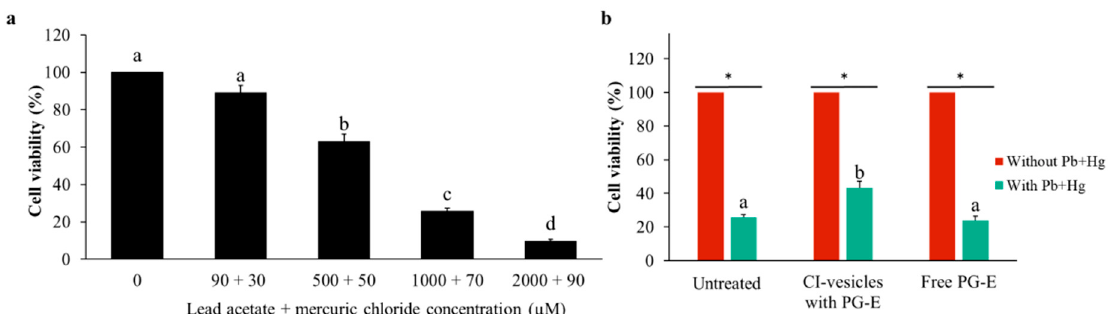
Figure 6. Viability (determined by the MTT assay) of HaCaT cells incubated for 24 h with different combinations of lead acetate and mercuric chloride ( µ M) ( a ) and treated for 24 h with cauliflower inflorescence vesicles (CI-vesicles) with pomegranate extract (PG-E) or free PG-E previous to the application of heavy metals (1000 µ M lead acetate + 70 µ M mercuric chloride) ( b ). The results were normalized as a function of the control cytotoxicity. Data are means ± SE ( n = 6). Different letters indicate significant differences between groups. *, significant differences compared to the respective control ( p < 0.05).